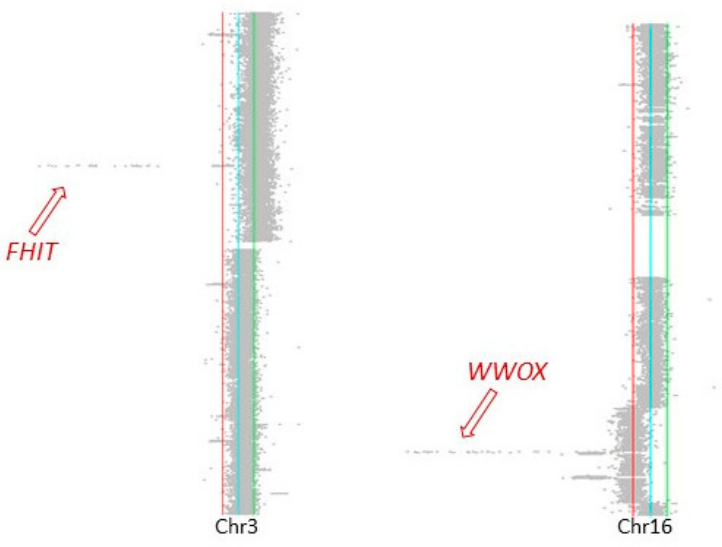
Figure 8. Focal deletions of FHIT and WWOX due to expression of FRA3B and FRA16D. Array CGH results for HaCaT versus HaCaT/SM for chromosome 3 and 16. Green and red lines indicate log 2 ratios of 0.4 and − 0.4, respectively. Arrows point to the deletions encompassing FHIT and WWOX .